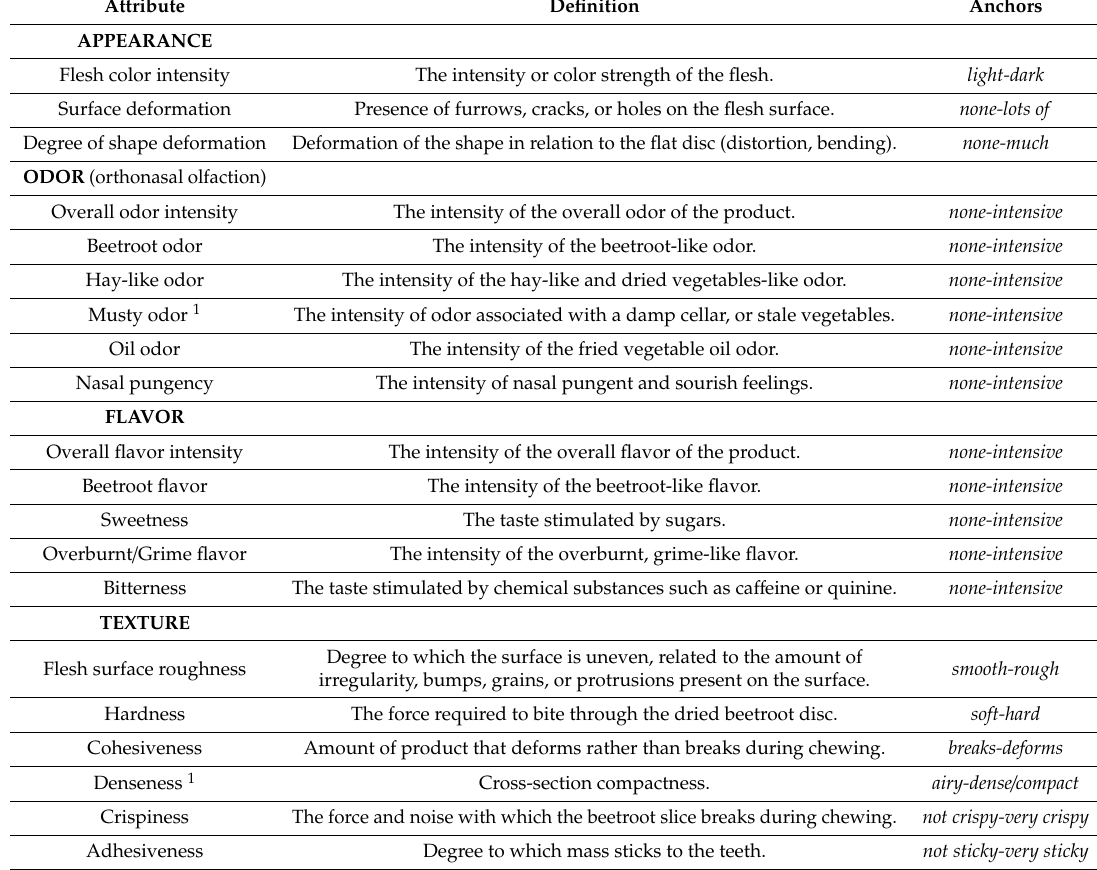
Table 1. The list of sensory properties and descriptors used in the descriptive sensory evaluation of dried beetroot